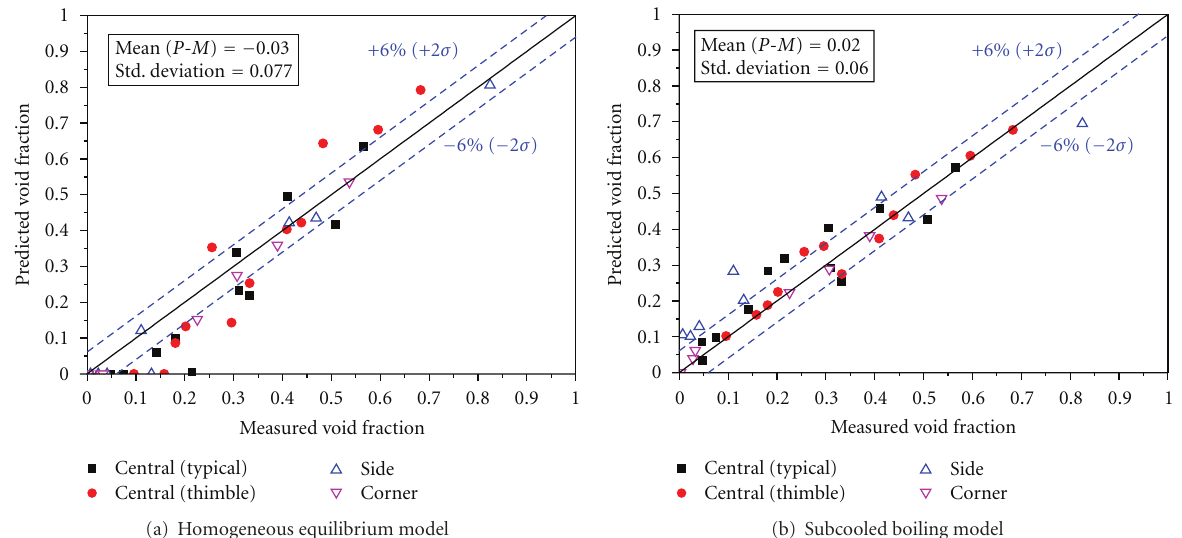
Figure 2: Prediction of single-channel void fraction using di ff erent void